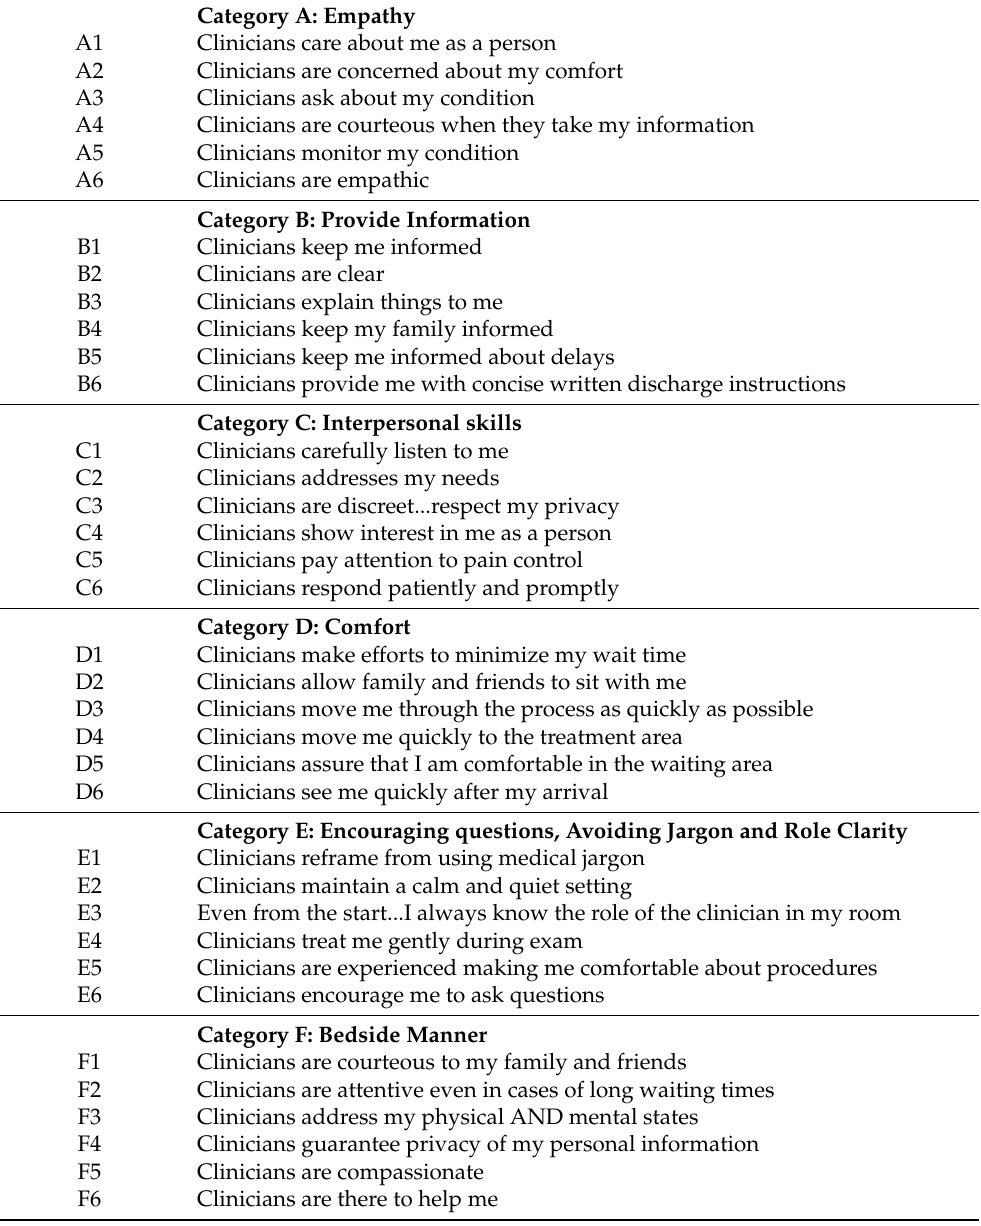
Table 2. Six Categories and Six Messages in Each comprising the